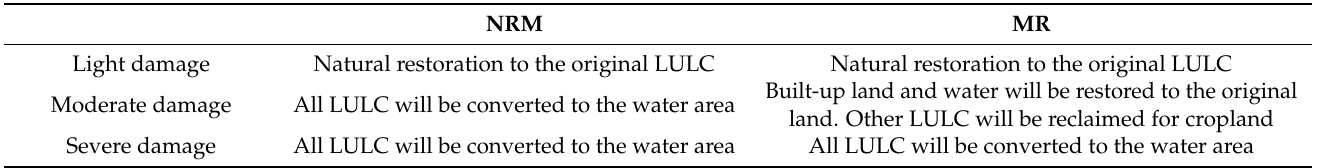
Table 2. Land conversion rules in NRM and MR